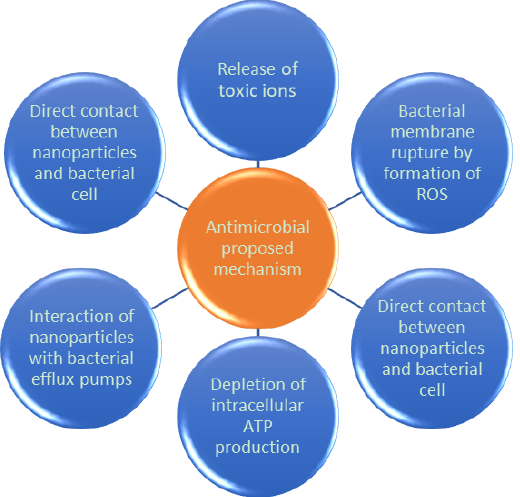
Figure 9. Proposed action mechanisms for the antimicrobial activity of nanoparticles (NPs).